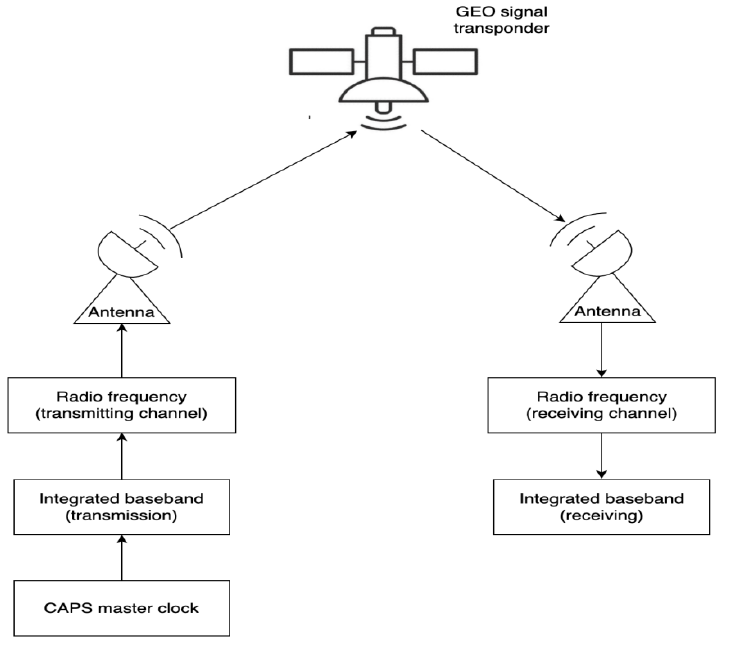
Figure 4. The realization process of the ground station transmitting and receiving the navigation signals.